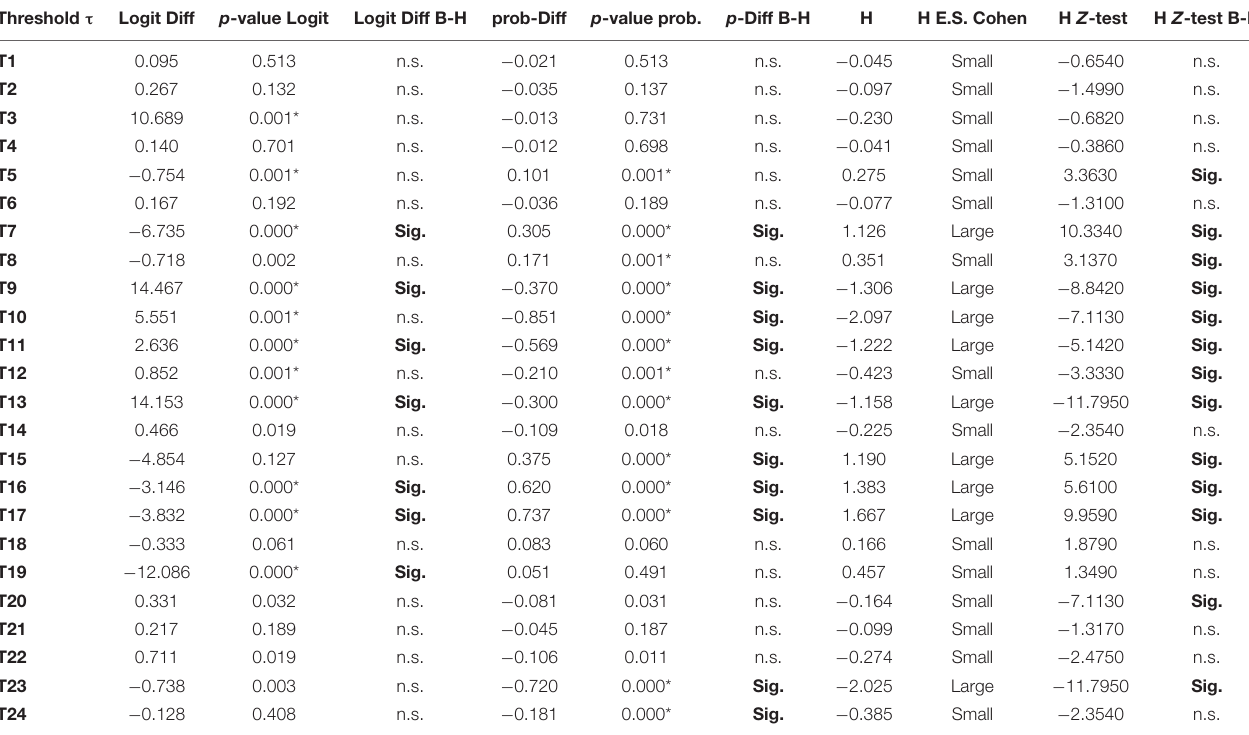
TABLE 5 | Differences between thresholds across waves (2016 vs. 2017) using logit and probability difference